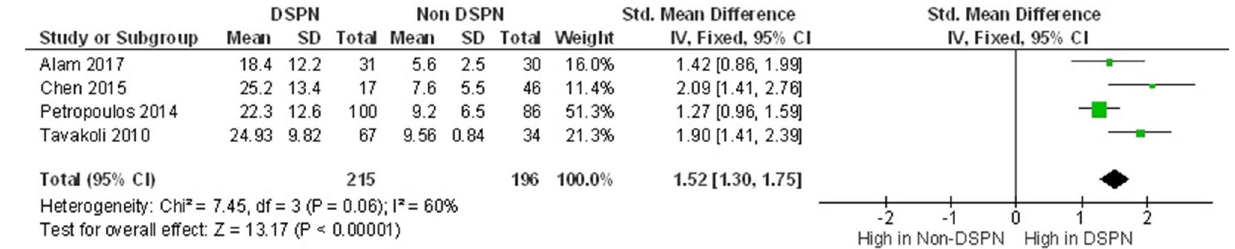
Figure 5. Forest plots for vibration perception threshold (VPT) comparing DSPN and Non-DSPN